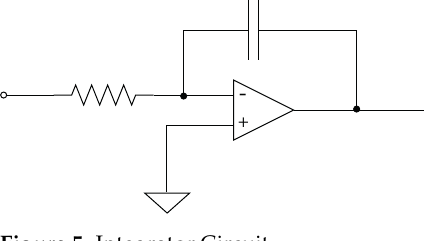
Figure 5. Integrator Circuit.